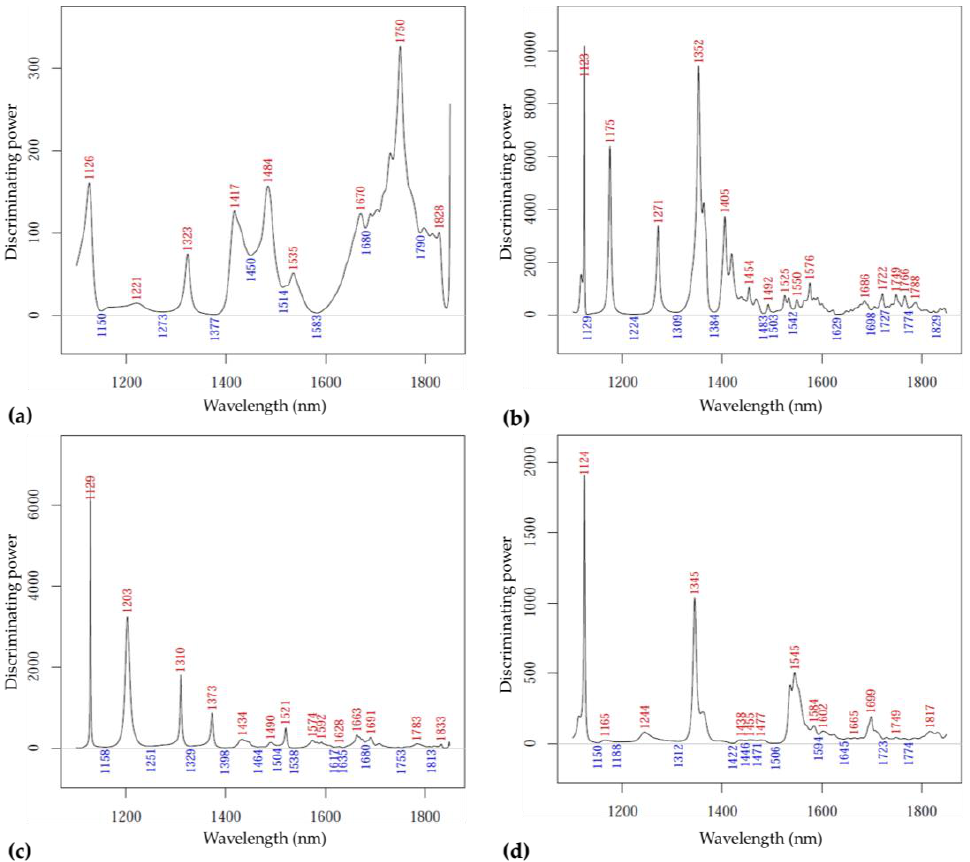
Figure 14. The SIMCA discriminating power plots for packaging: ( a ) results of ‘Kántorjánosi’ samples on day 1 ( n = 28, k = 2); ( b ) results of ‘Újfehértói fürtös’ samples on day 1 ( n = 33, k = 4); ( c ) results of ‘Kántorjánosi’ samples on day 10 ( n = 33, k = 4); ( d ) results of ‘Újfehértói fürtös’ samples on day 10 ( n = 33, k = 3).